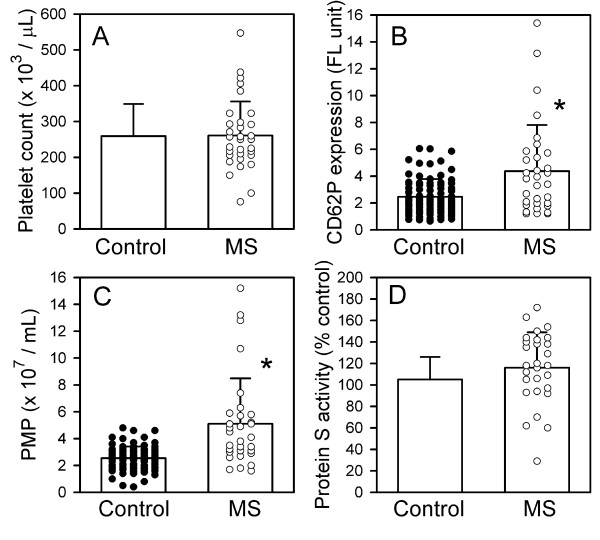
Comparison of platelet count, platelet activation marker CD62P expression, PMP, and protein S between controls and MS patients. (A) Mean platelet counts did not differ between the MS and control groups. (B) Elevation of platelet activation marker CD62p in the MS group was highly significant, *P < 0.001. Not shown or included in the analysis was one extremely high value (60.6), possibly a technical error. (C) PMP counts in the MS patients were significantly higher than controls, *p < 0.001. Not shown or included in the analysis was one very high outlying value (25.2). (D) Protein S activity (% control) did not differ significantly between MS and controls. All values are expressed as mean ± SD. The institutional control values (mean ± SD) of platelet count and protein S activity were obtained from the laboratory of University of Miami Hospital and Clinics, and are not shown as individual dots because the numbers are too large.